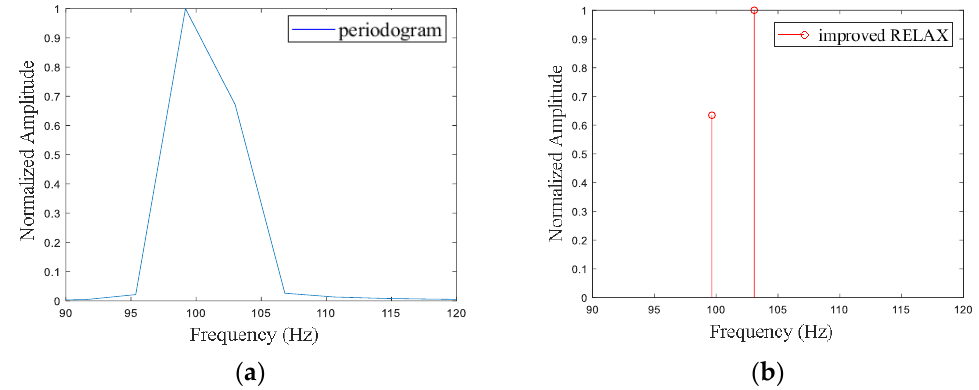
Figure 5. Estimation results of ( a ) periodogram and ( b ) improved RELAX algorithm.